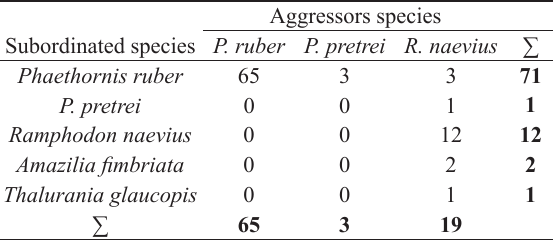
Agonistic interactions between species of flower-visiting hummingbirds in 10 individuals of the plant Dahlstedtia pinnata monitored between August 2010 and August 2011 in Pedra Branca State Park, Rio de Janeiro. Aggressors species Subordinated species P. ruber P. pretrei R. naevius